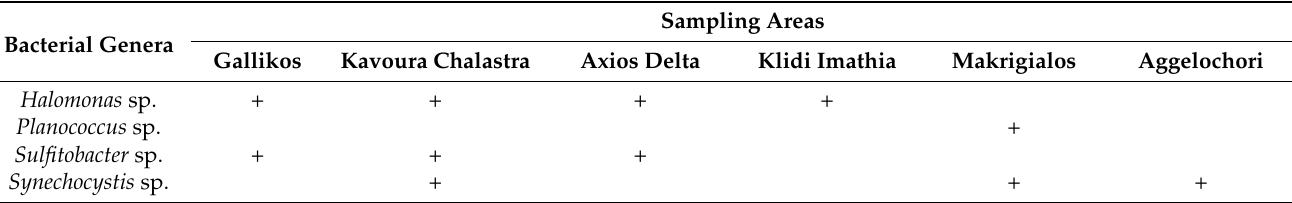
Table 1. Geographical distribution of the detected bacterial